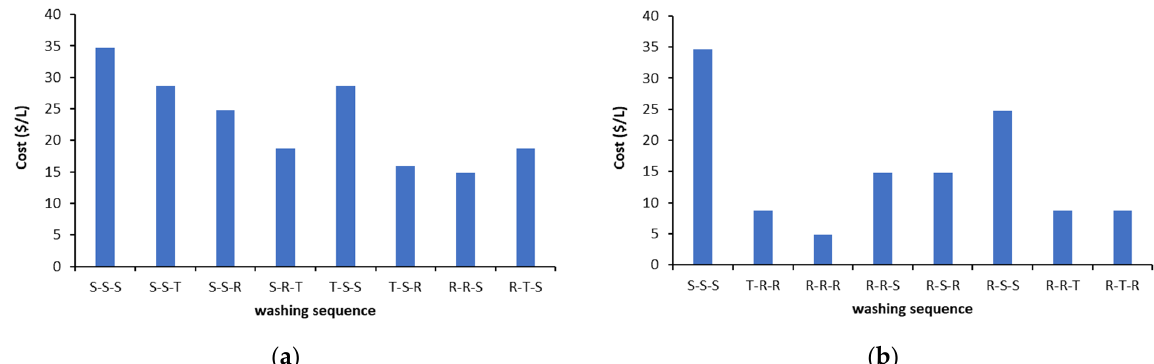
Figure 11. Comparison of relative cost for the most effective sequences for treatment of smelter contaminated soil selected on the basis of metal removal, metal stability and organic carbon enrichment: ( a ) Cu, ( b ) Pb.